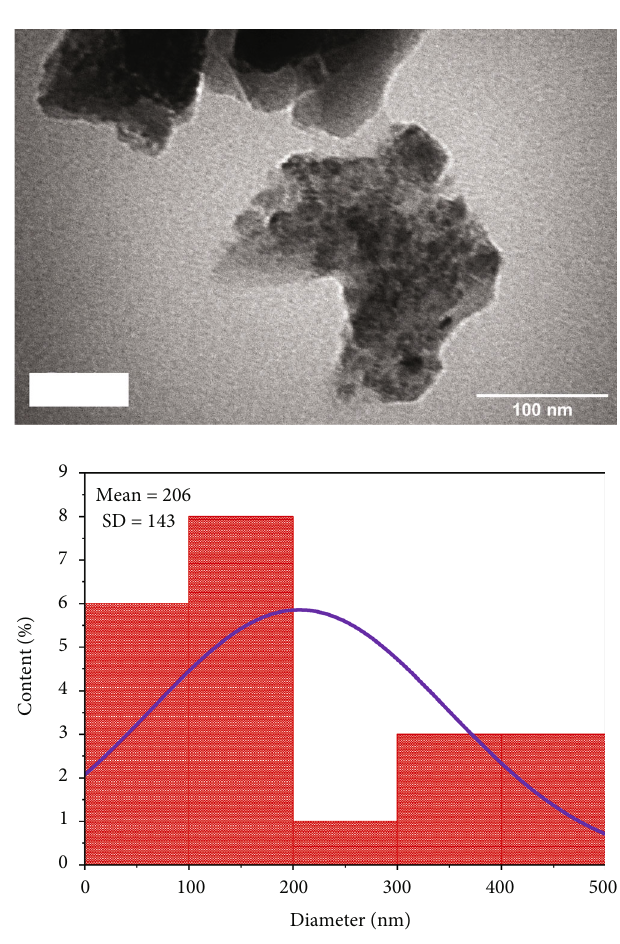
Figure 11: TEM of m-PNPs and particles size distribution.